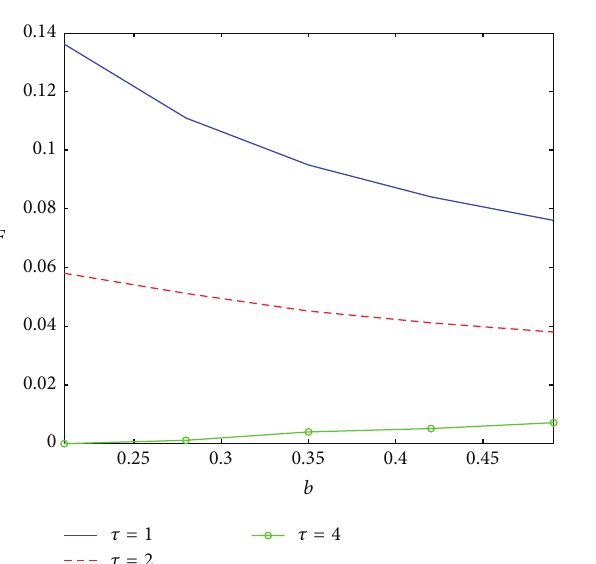
Figure 4: Impact of 𝛾 𝑢 on sampling level.